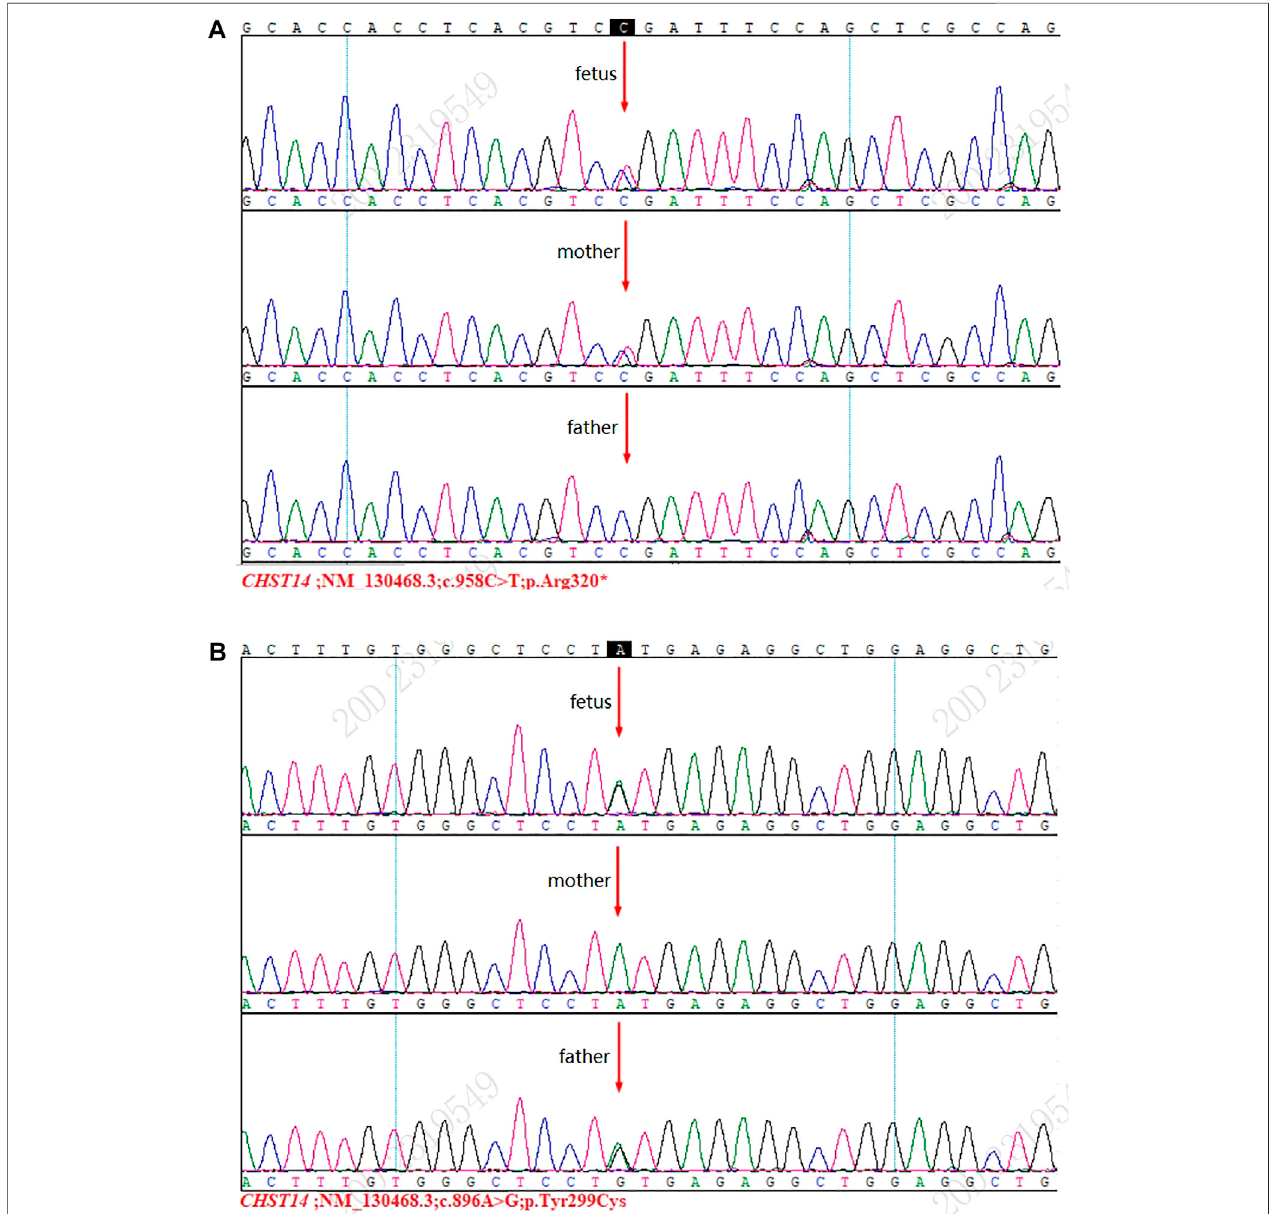
FIGURE 1 | Results of Sanger sequencing. (A) Mutation [NM_130468.3 c.958C > T (p.Arg320*)] was detected in the fetus and the mother. (B) Mutation [NM_130468.3 c.896A > G (p.Tyr299Cys)] was detected in the fetus and the father.